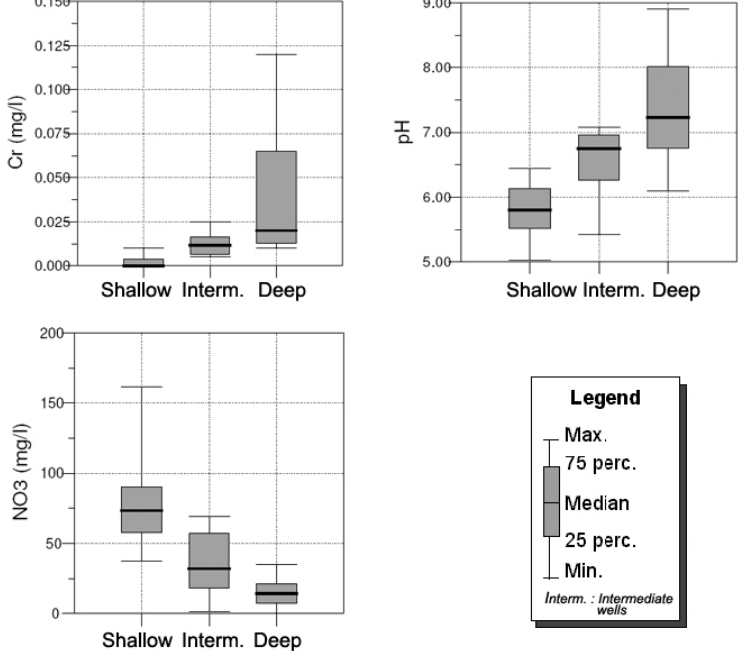
Fig. 4 – Box plots showing a comparison of chromium, pH and nitrate distribution for groundwater samples from shallow, intermediate and deep